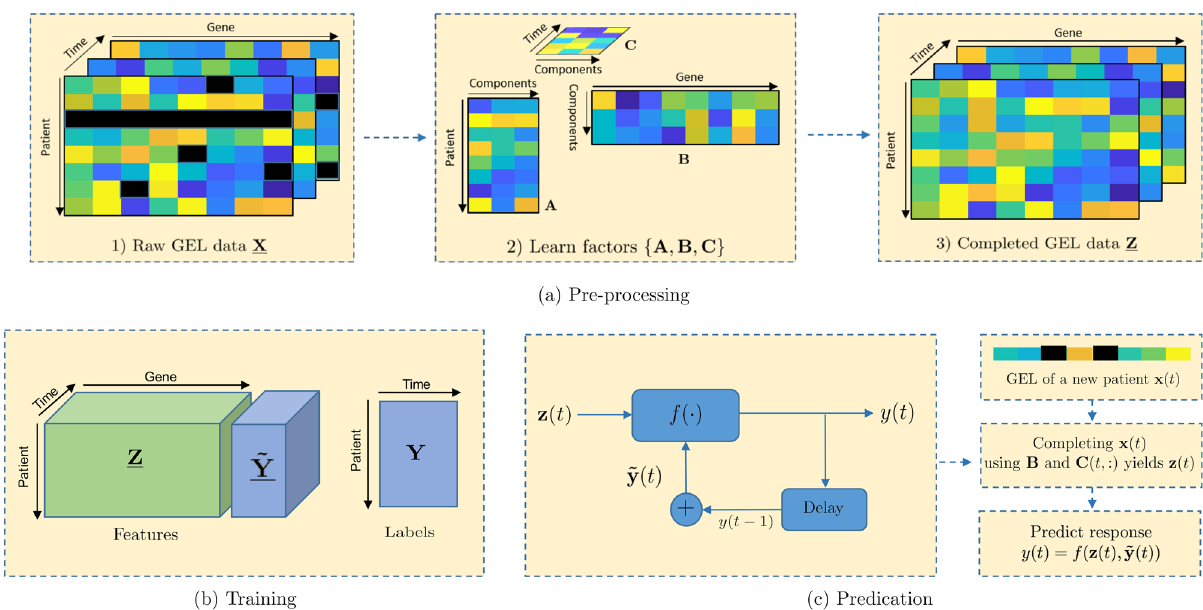
Figure 1. Sketch view of the proposed method. In ( a ), Step (1) shows the raw data X with missing values marked as ‘black’; Step (2) shows the low-rank tensor factorization; Step (3) is the missing completion, where Z = P X ) + P G ) . In ( b ), it shows the composition of training data: features and labels. In ( c ), it shows the � ( � c ( prediction for new patient at a specific time t